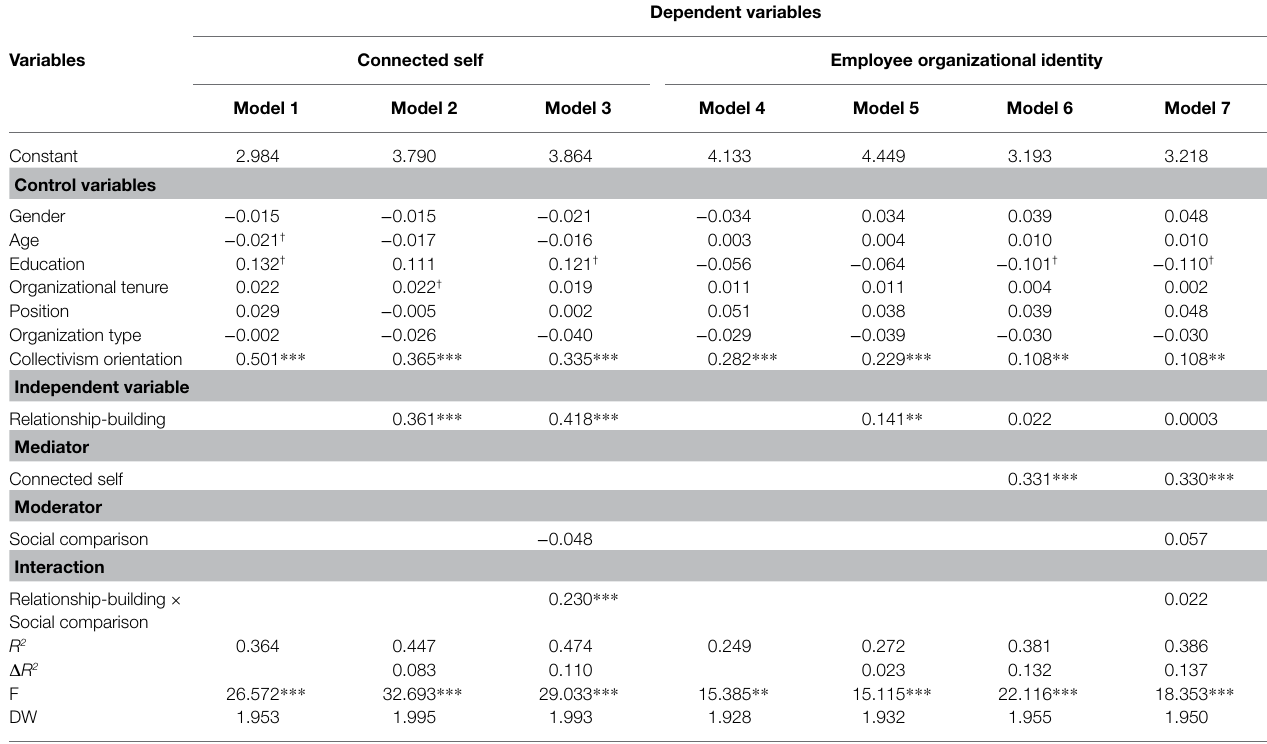
TABLE 3 | Results of regression analysis.